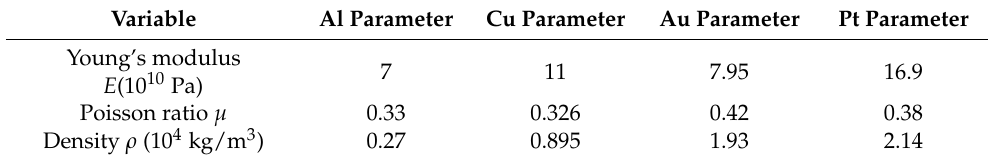
Table 2. Material parameters of electrodes.